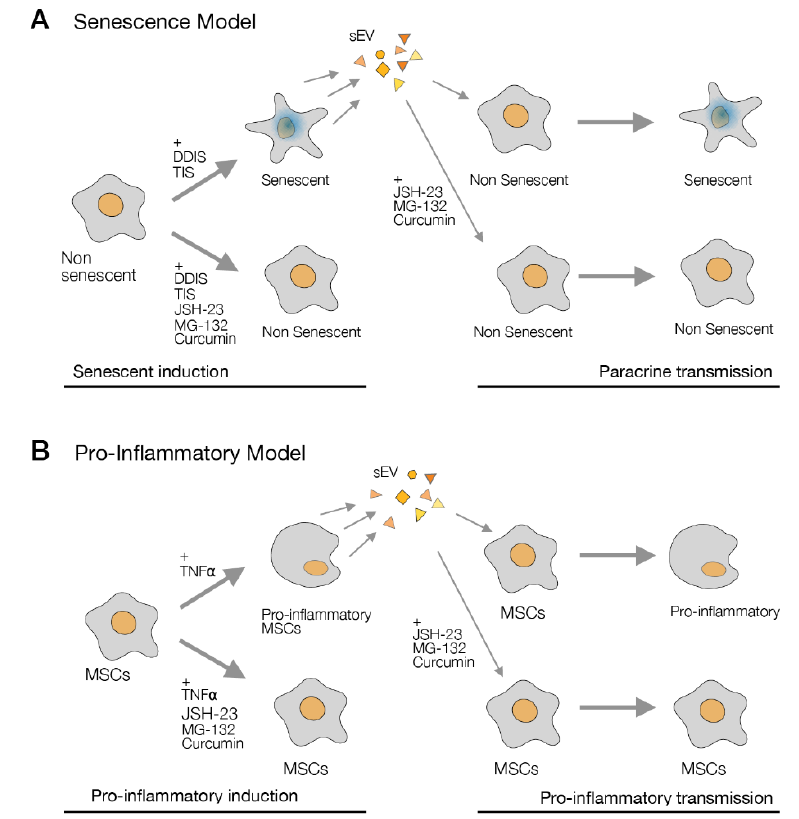
Figure 10. Graphical abstract the role of p65 in inflamm-aging in mesenchymal stem cells (MSCs). (A ) The use of JSH-23, MG-132 and curcumin blocks the senescence induction (left), and the inhibition of the p65 pathway prevents the paracrine senescence transmission by sEV in human MSCs (right). ( B ) The p65 pathway is involved in the proinflammatory activation in MSCs (left) and the proinflammatory transmission paracrine by small extracellular vesicles (sEV) (right). DDIS: DNA damage-induced senescence, TIS: therapy-induced senescence and TNF-α: tumor necrosis factor alpha.